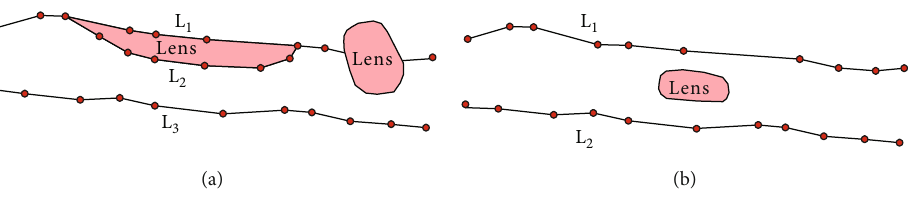
Figure 3: Processing of lens body.